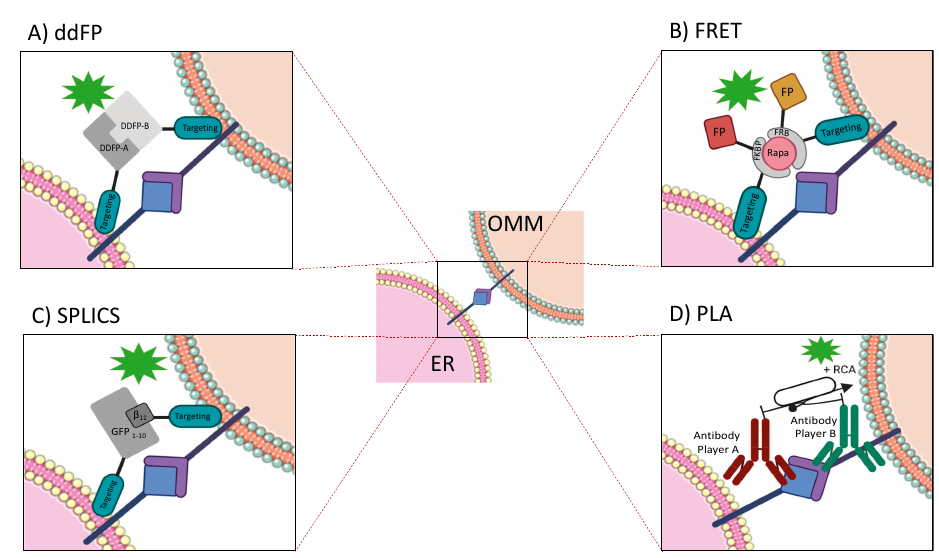
Figure 2. Representation of methods useful to detect proximity interaction between the ER and the outer mitochondria membrane (OMM). The diagram in the center is a schematic interaction of contact site resident proteins at the ER and OMM interface. ( A ) Dimerization-dependent fluorescent proteins (ddFP). The interaction of two dark fluorescent protein (FP) monomers, targeted on organelle interface, recreates a detectable fluorescent heterodimeric complex. ( B ) Fluorescence resonance energy transfer (FRET). Detection of energy transfer between two proximity fluorophores targeted to organelles of interest after rapamycin addition. Fluorophores consist of organelle targeting sequences, rapamycin-induced dimerization domains, and fluorescent proteins. ( C ) Split-GFP-based contact site sensor (SPLICS). The interaction between two proximity non-fluorescent portions of the superfolder GFP variant, the β -strands 1–10, and the β -strand 11 of the GFP spontaneously reconstitutes the complete β -barrel structure of the fluorescence-emitting GFP. ( D ) Proximity ligation assay (PLA). Two antibodies against proteins of interest are attached to oligonucleotides that guide the formation of circular DNA strands when proteins are close enough. The addition of rolling-circle amplification (RCA) permits the detection of protein interaction.